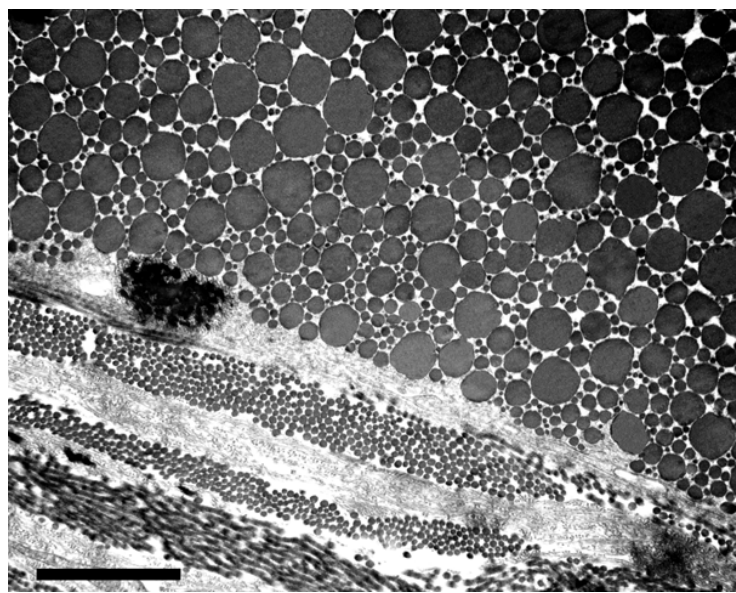
FIGURE 3. TEM section of rat Achilles tendon. Transversally sectioned tendon including plurimodal collagen fibrils (top) and unimodal fibrils of paratenon (bottom). Between tendon collagen fibers and paratenon elastic fibers are visible (dark stained). Bar = 1 μ m